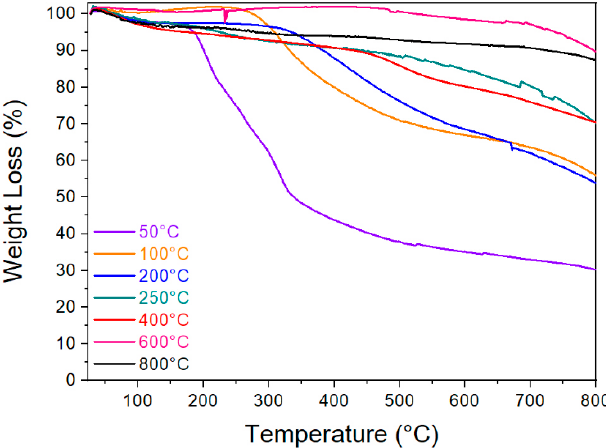
Figure 3. Thermogravimetric analysis of carrot pulp stabilized and carbonized at temperatures between 50 and 800 °C.